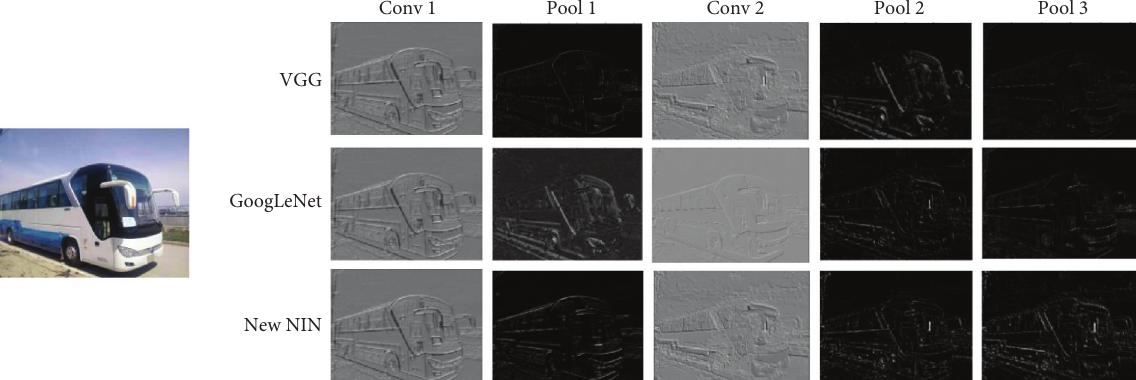
Figure 4: Visualization of activation values in the middle layer of three types of convolutional neural network models.